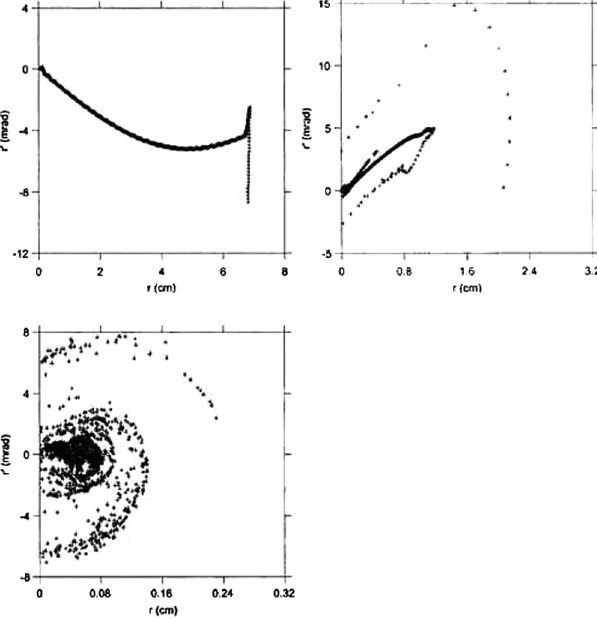
FIG. 4. Numerically modeled radial phase space of a beam in an induction linac [10]. (Top left) just after the electron gun, about 4 MeV; (top right) after a few MeV of acceleration and betatron periods; (bottom) at the end of the linac, about 20 MeV; images are from